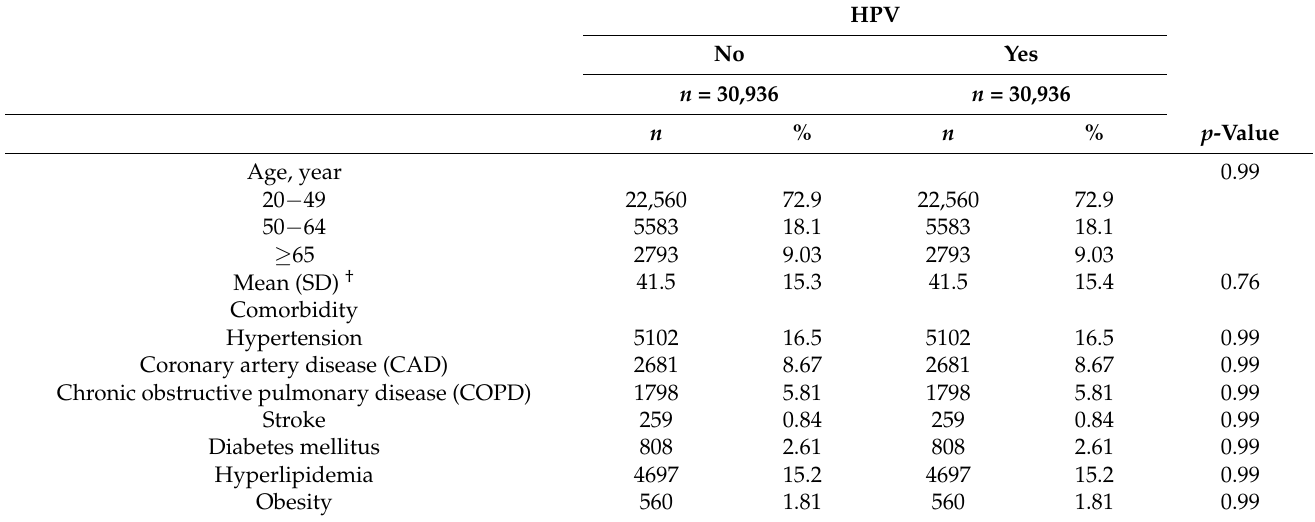
Table 1. Baseline characteristics of individuals with and without HPV.